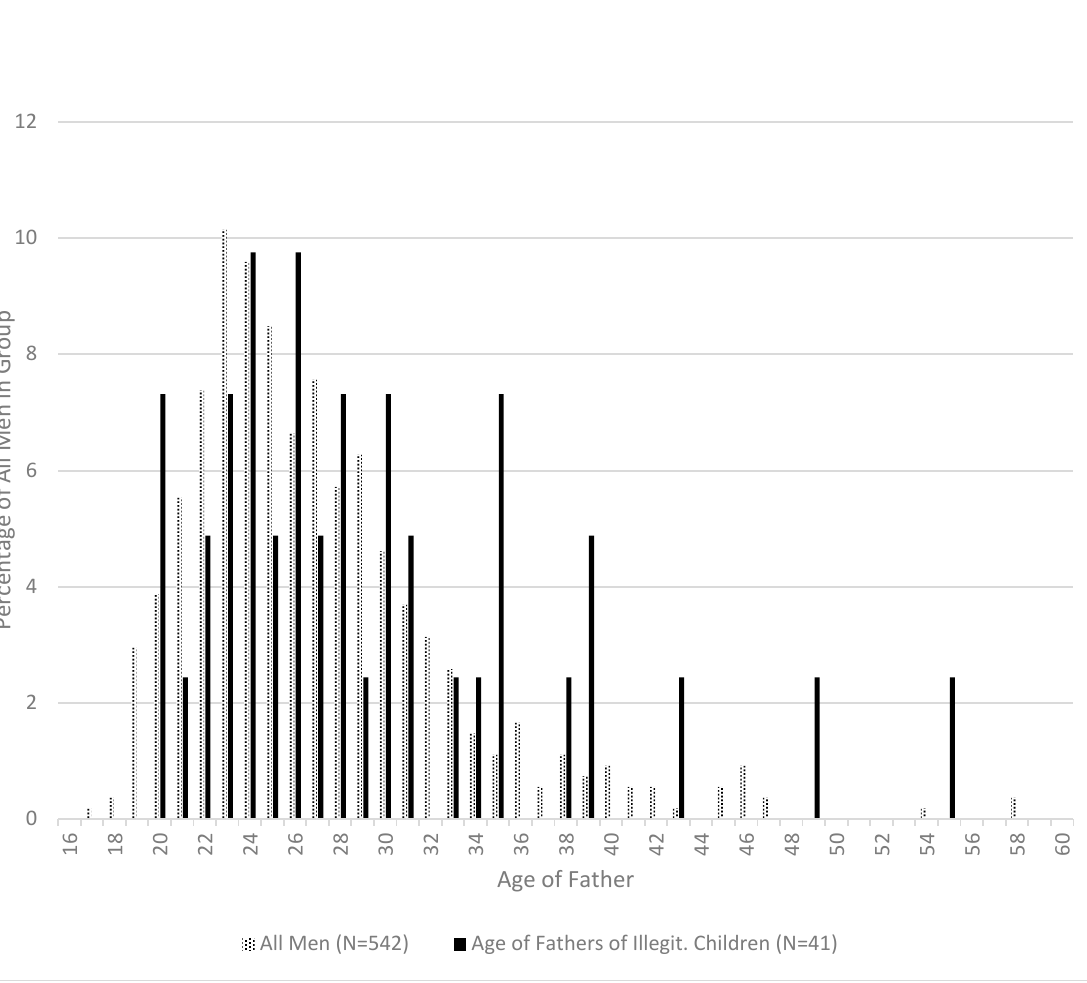
Figure 6. Age At Which Men Registered First Children, All Men vs. Fathers of Illegitimate Children, Butleigh, Somerset, 1762–1834.